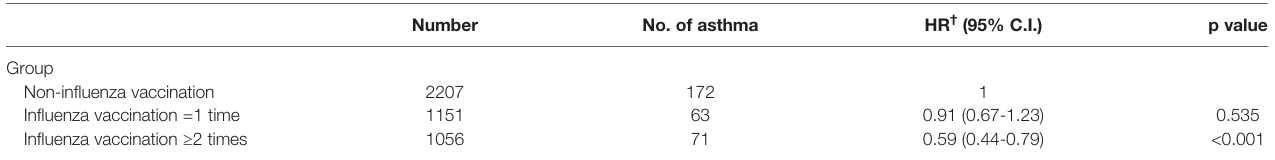
TABLE 5 | in fl uenza vaccination dose response on asthma risk reduction.